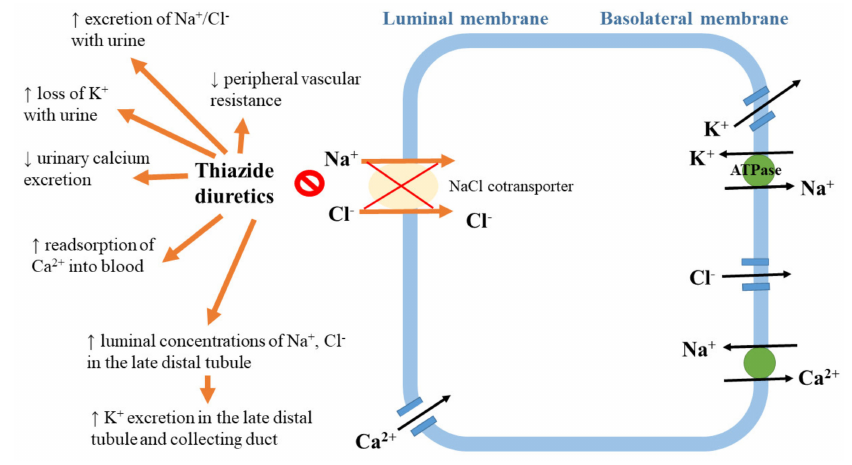
Figure 4. E ff ects of action of thiazide